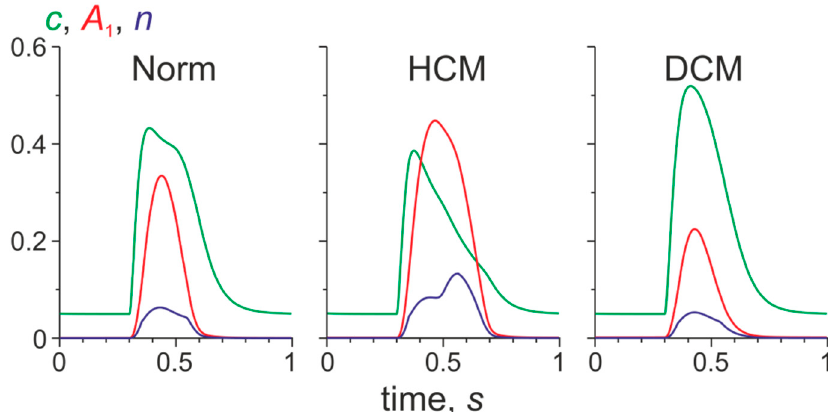
Figure 3. The time course of the normalized Ca 2+ concentration in the cytosol ( c ), the level of activation of the Tpm–Tn (troponin) system in the overlap zone of sarcomeres ( A 1 ), and the fraction of myosin heads bound to actin ( n ) in a mid-wall finite element located near the LV equator. The results obtained in the normal LV model (Norm) and those with normal LV geometry and cell-level parameters characteristic for the HCM and for DCM Tpm mutations are shown.